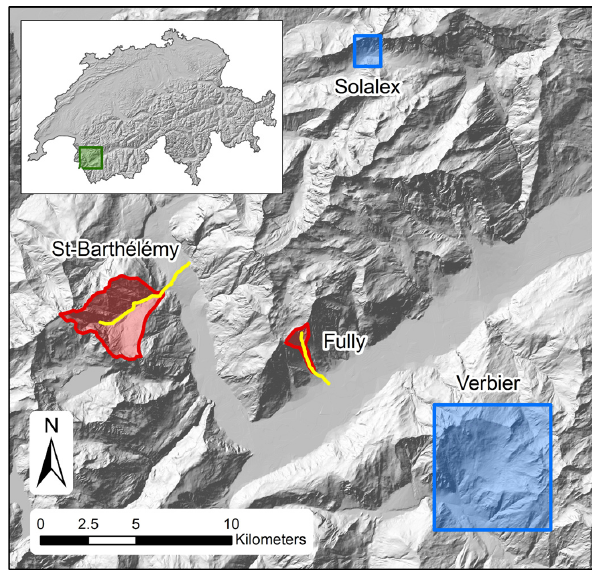
Fig. 8. Location of the case studies in the Swiss Alps. The catch- ments are displayed in red for Saint-Barth´el´emy and Fully, along with the location of the longitudinal profiles (yellow) given in Fig. 13. The extent of the Solalex case study (Fig. 9) and the Ver- bier area (Fig. 16) are depicted in blue (Geodata ©swisstopo –